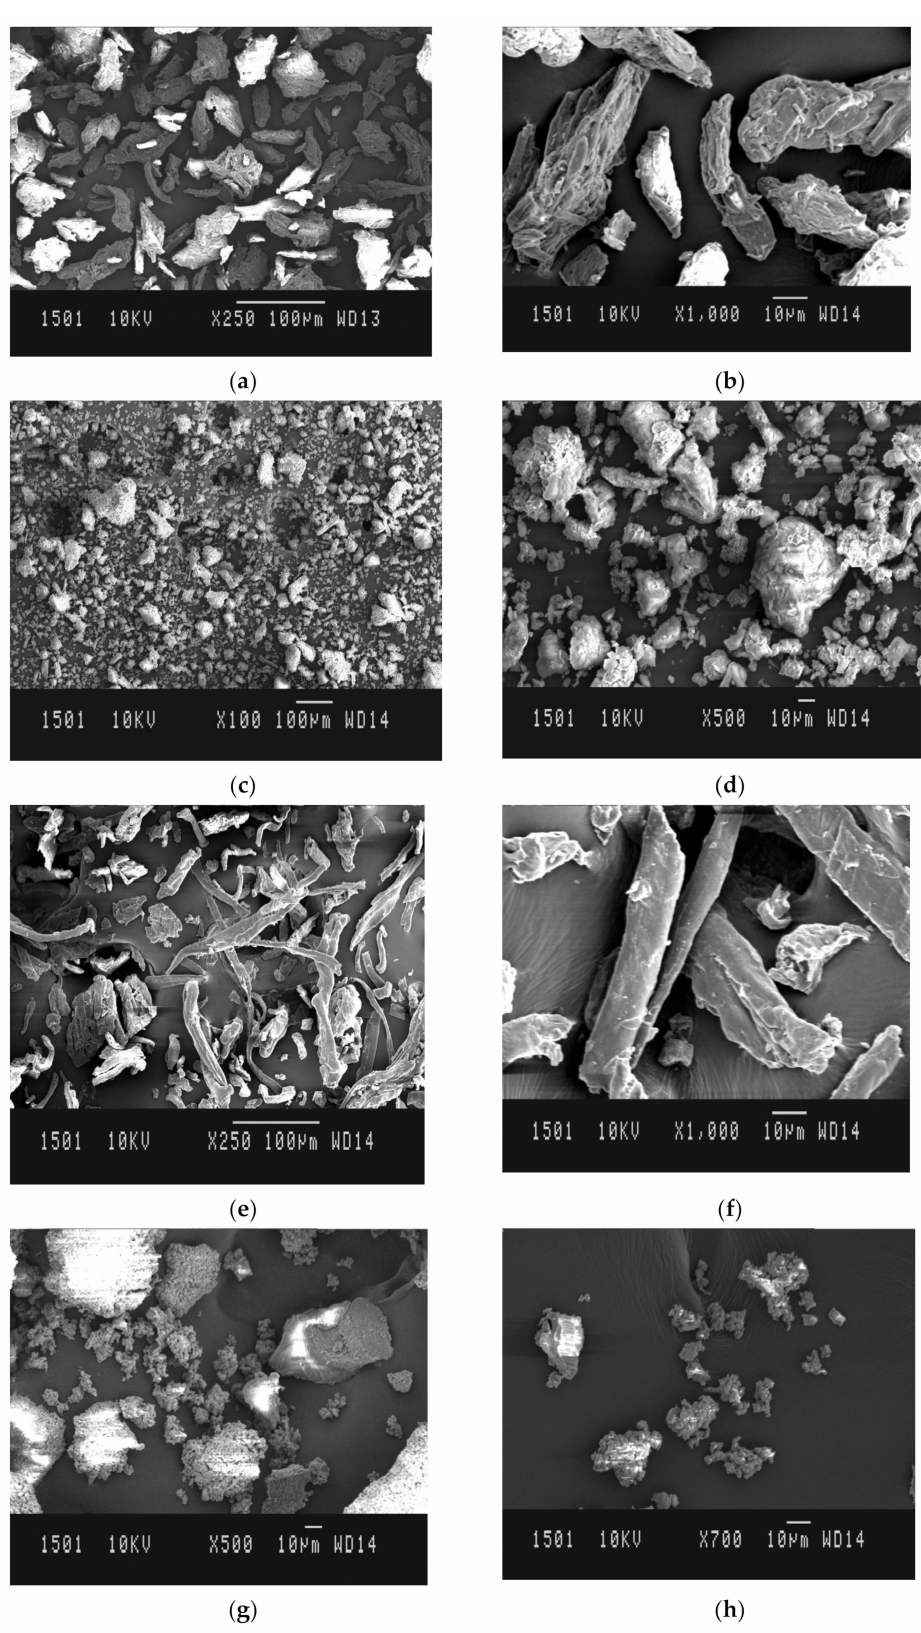
Figure 4. SEM photomicrograph of ( a , b ) MCC, ( c , d ) MCC-SiO 2 conjugates prepared in the ratio 1:5, ( e , f ) CMC, and ( g , h ) CMC-SiO 2 conjugates prepared in the ratio